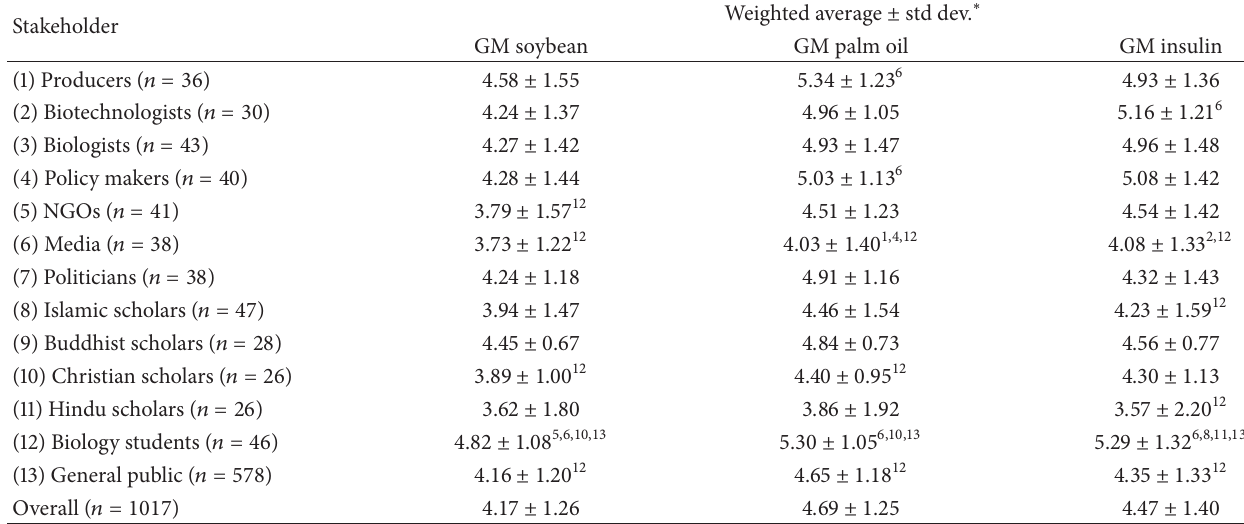
Table 5: Weighted average and post hoc test results for perceived benefit of GM foods and GM insulin.